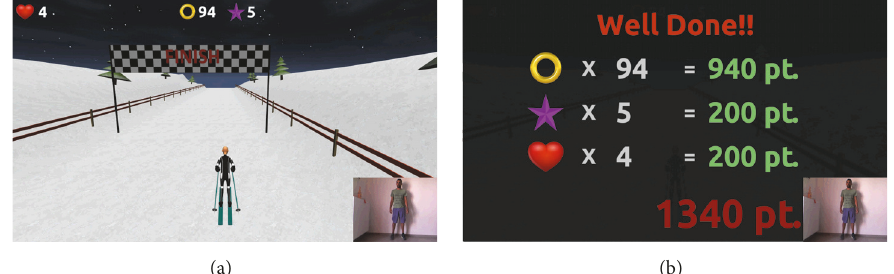
Figure 16: Slope Creep game. (a) Sample screenshot showing the avatar reaching the finish line, followed by (b) a detailed account of the human actor’s